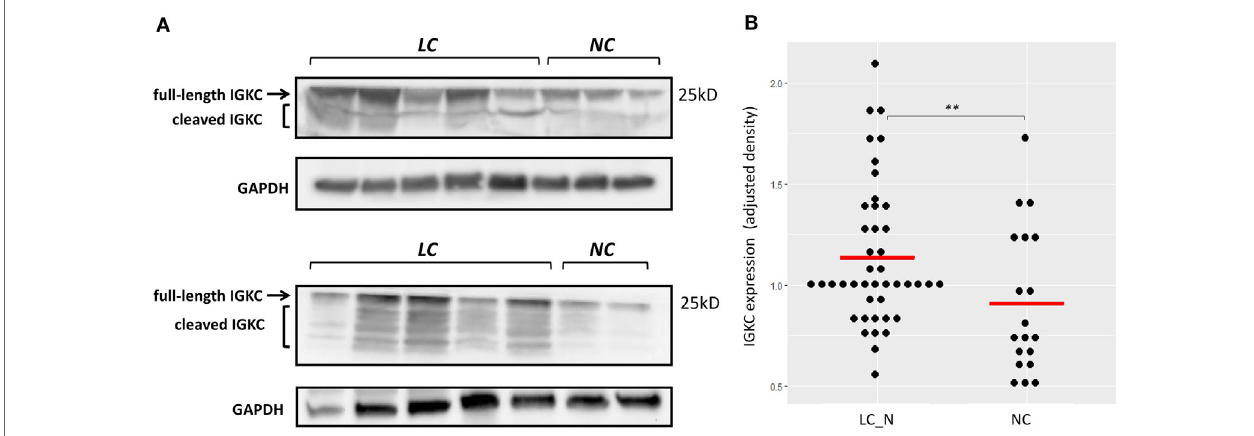
FigUre 8 | (a) Representative immunoblotting showing increased IGKC expression of the bronchoalveolar lavage (BAL) cell lysates of non-small cell lung cancer subjects (LC) compared to the BAL cell lysates of normal controls (NC). (B) Quantitative analysis of the expression of IGKC, density adjusted to GAPDH, between LC ( n = 43) and NC ( n = 19). ** p < 0.01 by Wilcoxon signed-ranked